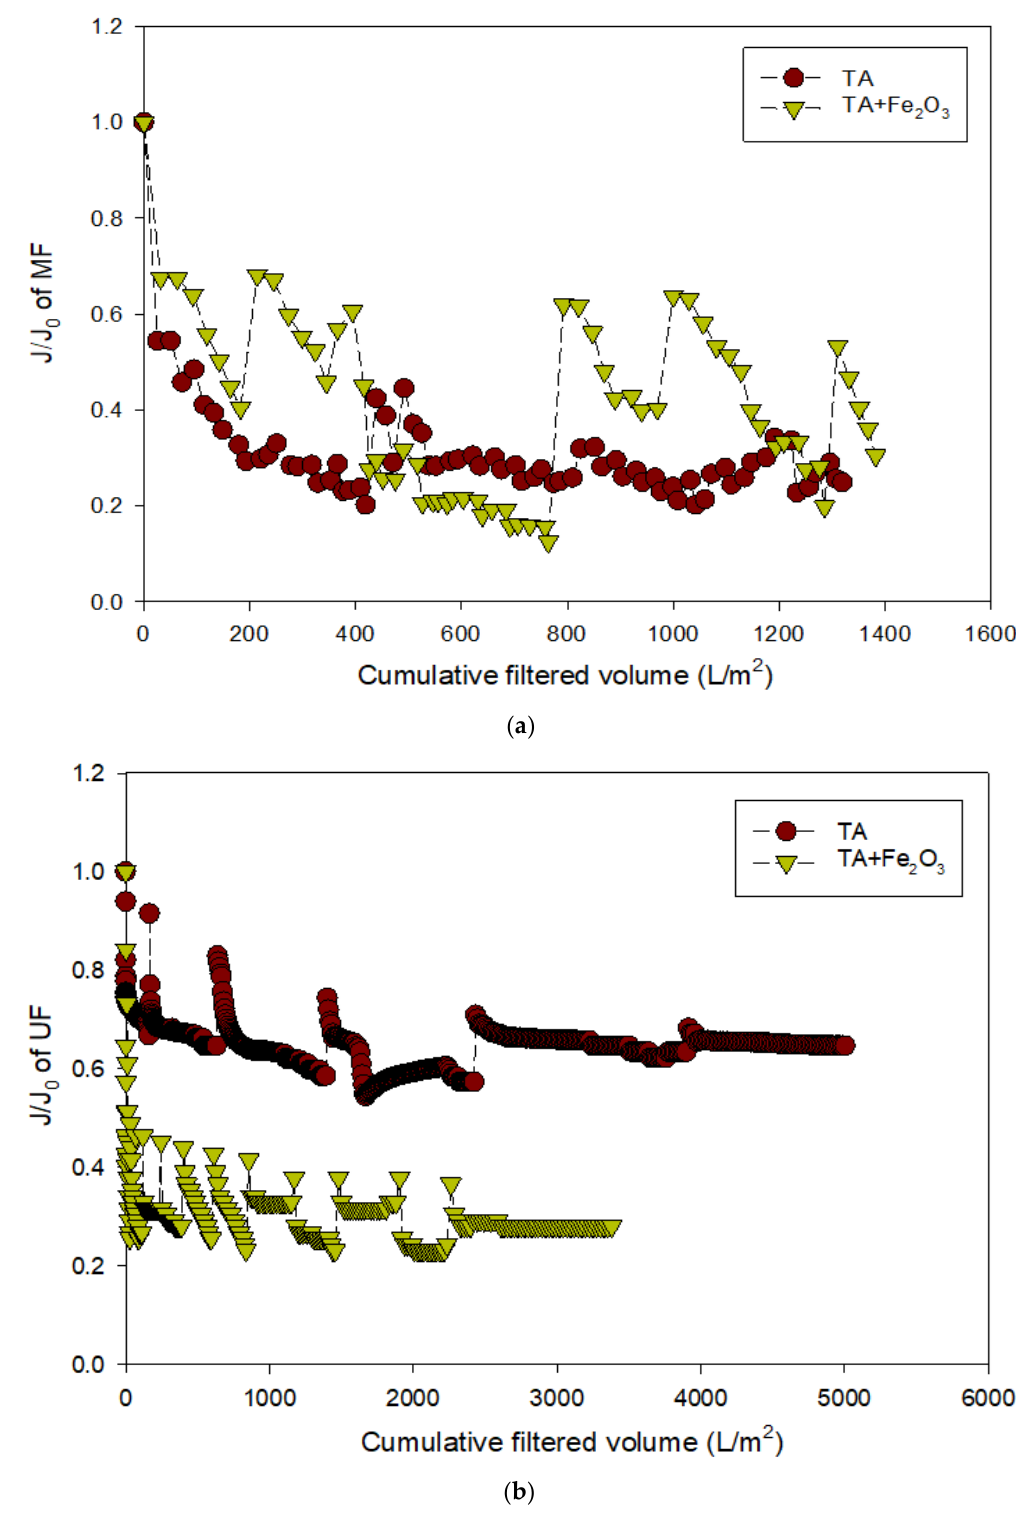
Figure A7. Flux decline at filtering tannic acid and tannic acid + Fe 2 O 3 feed waters: ( a ) MF and ( b )